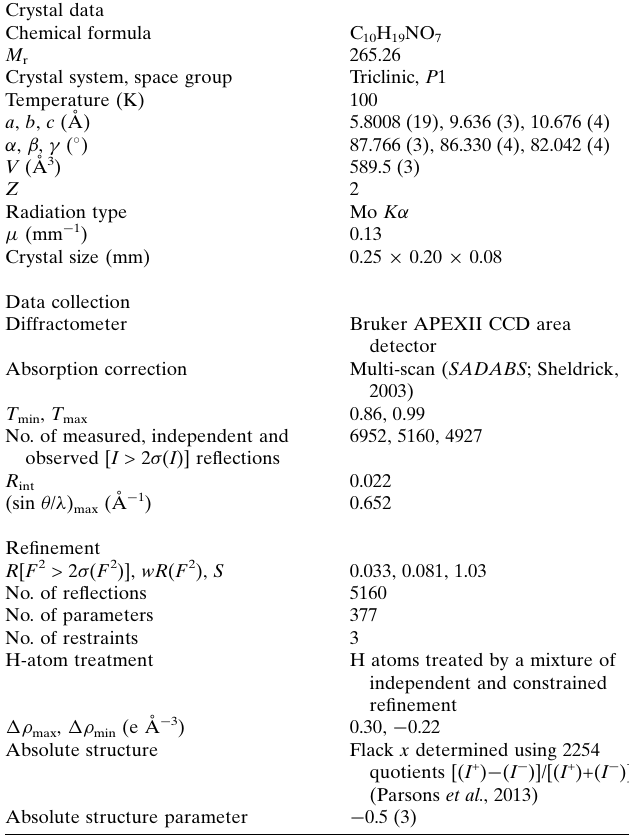
Crystal data Chemical